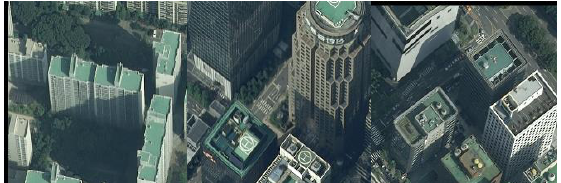
Figure 2. Relief displacements of high-rise buildings in the aerial images